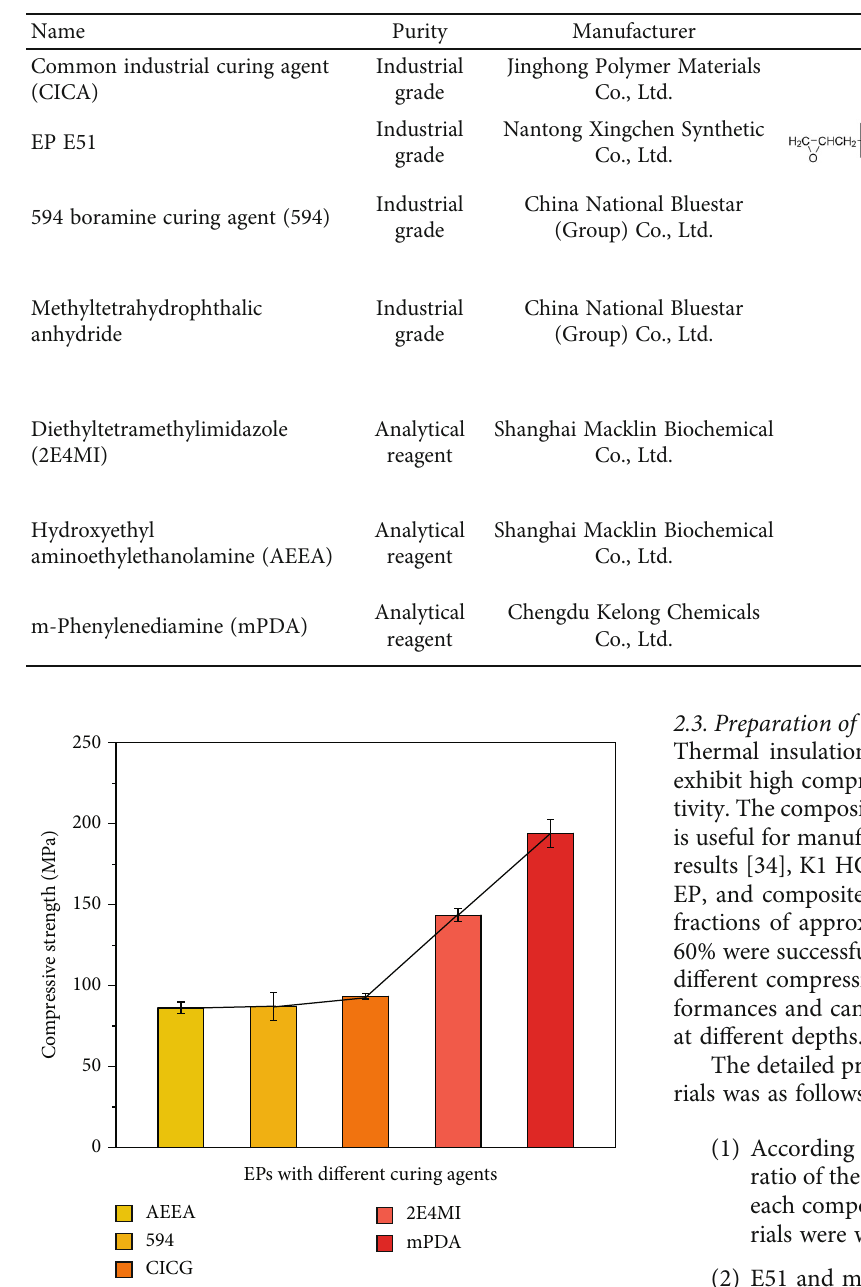
Table 1: Information on experimental materials.